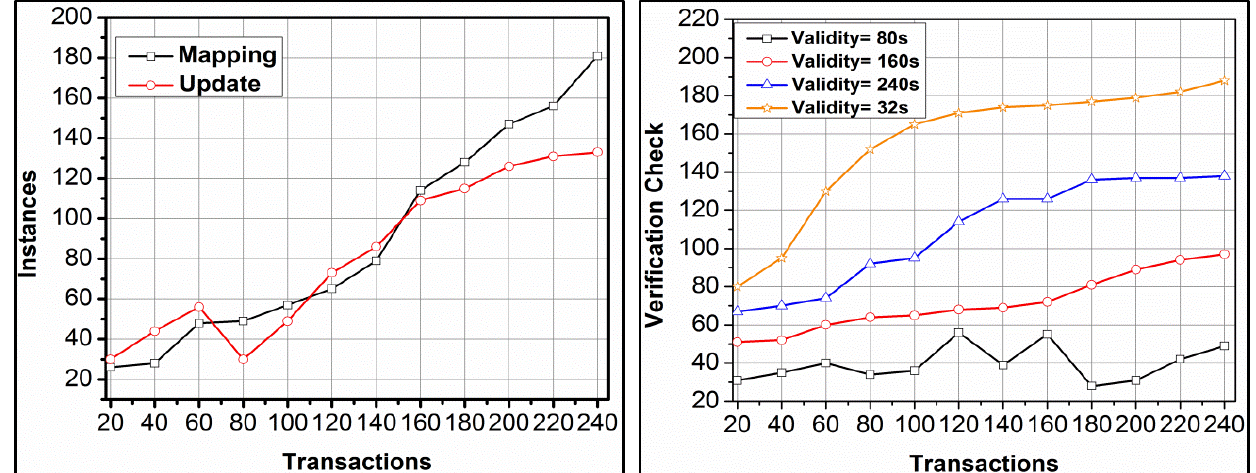
Figure 5. Mapping and updating, and verification checks under different transactions.